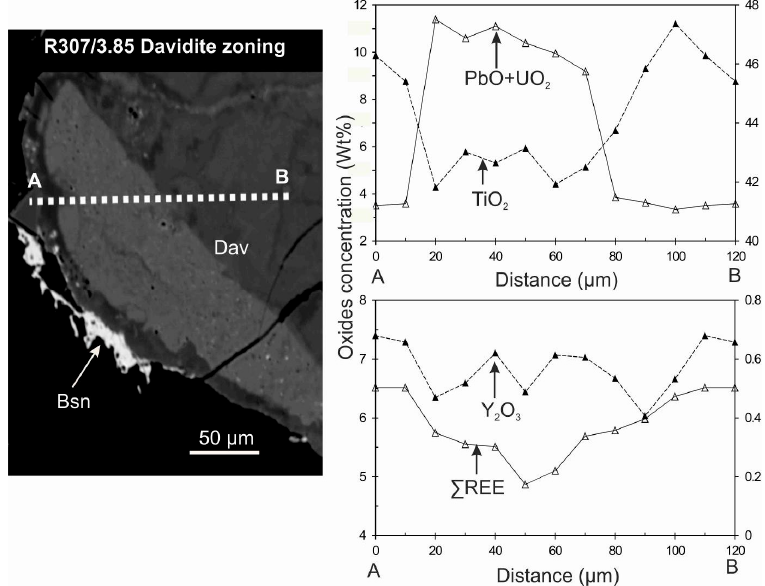
Figure 13. Back-scattered electron image of patchy chemical zoning of davidite (sample R307/3.85) as crichtonite group mineral. EPMA line scans across davidite zones corresponds to variation in the TiO 2 , PbO + UO 2 , Y 2 O 3 and REE contents.